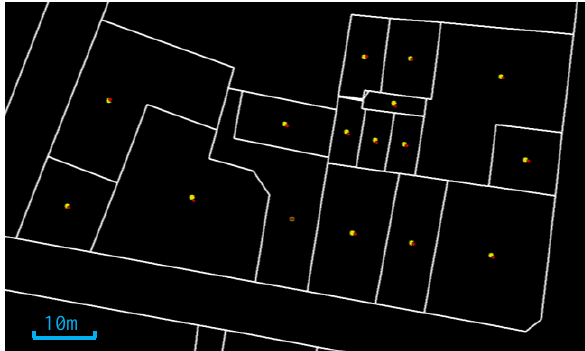
Figure 5. Comparison of estimated positions (red points) and ground truth (yellow